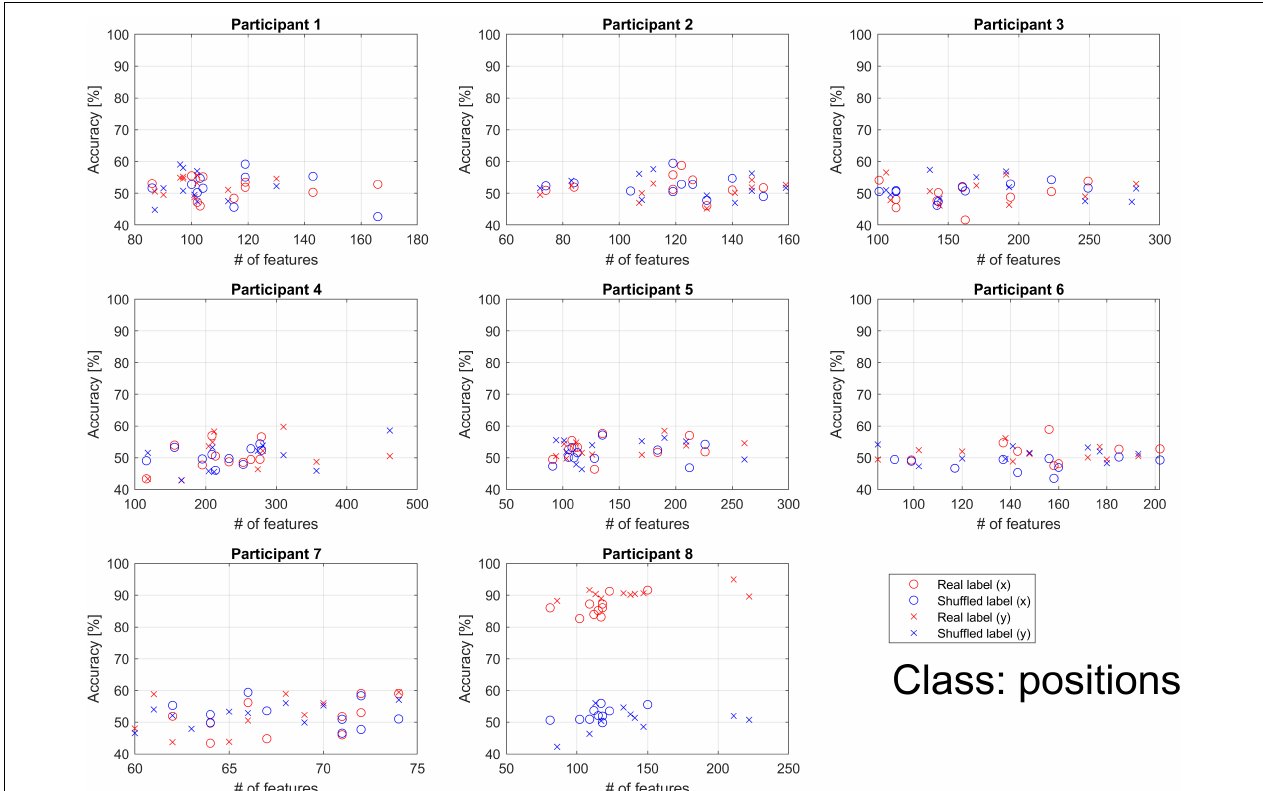
FIGURE 7 | Individual classification accuracies for x and y positions according to the number of features. Each dot represents accuracy for each binary classification. The binary classifications were performed 10 times (5 choose 2) per participant when the feature for all classifications had at least 1. Blue markers represent the results when shuffled labels were used. Red markers represent the results when real labels were used. The accuracy for the horizontal ( x ) position is represented using circles, while that for the vertical ( y ) position is represented using crosses. Performance of the real and shuffled labels did not depend on the number of features. Accuracy was better than chance level in participant 8 only. For other participants, accuracy was similar to that of chance